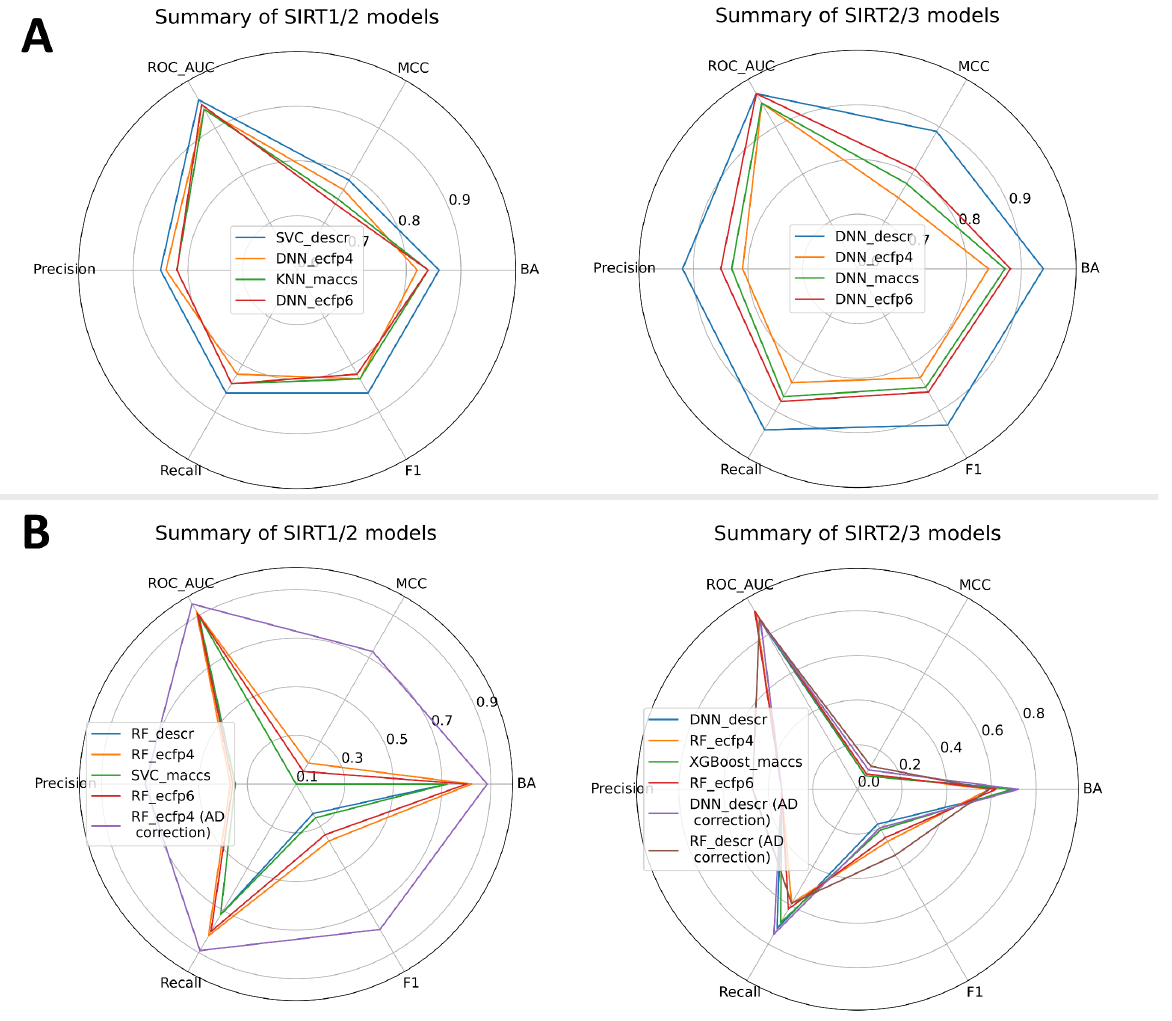
Figure 6. Summary of the predictive performances for multiclass selectivity models presenting the top-performing model across each feature type. ( A ) Validation parameters obtained for the external (test) set; ( B ) validation parameters obtained on the decoy set. Values of precision, recall and F1 are calculated as macro averages.